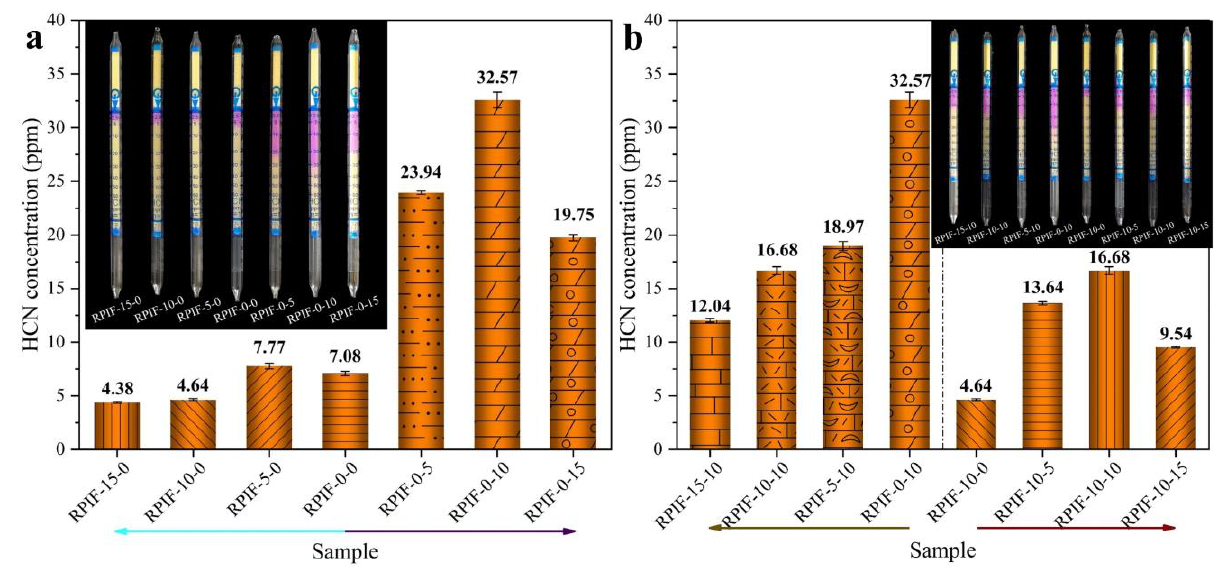
Figure 12. Difference and comparison of the effects of PPCP and EG on the HCN concentration of the RPIF combustion process, PPCP or EG alone used ( a ), and combination use of PPCP with EG ( b ).